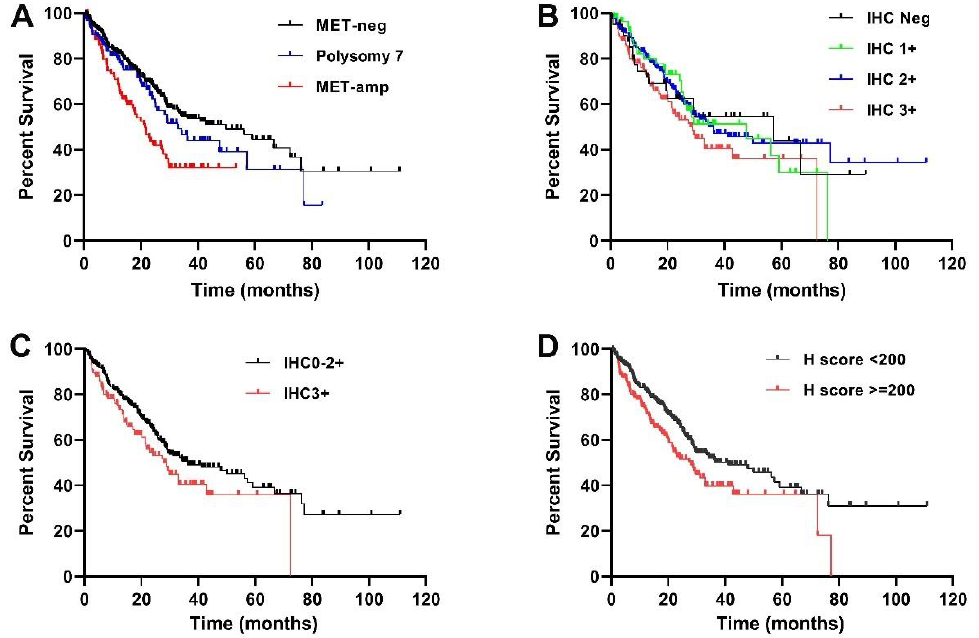
Figure 4. Overall survival (OS) by Kaplan-Meier analysis. ( A ): Comparison of OS among patients with MET-amp, polysomy 7 and MET-neg, patients in MET-amp group showed significantly inferior OS; ( B ): No significant difference of OS among patients of groups with of IHC-neg, IHC1+, IGHC2+ and IHC3+; ( C ): Patients with IHC3+ showed a significantly shorter OS comparing to patients with IHC0/1+/2+; ( D ): Patients with H- score ≥ 200 showed a significantly inferior OS comparing to patients with H score < 200. Table 3. Association of MET expression with survival by using IHC2+/IHC3+ or H-score ≥ 150 or ≥ 200 as cut-off (Kaplan-Meier